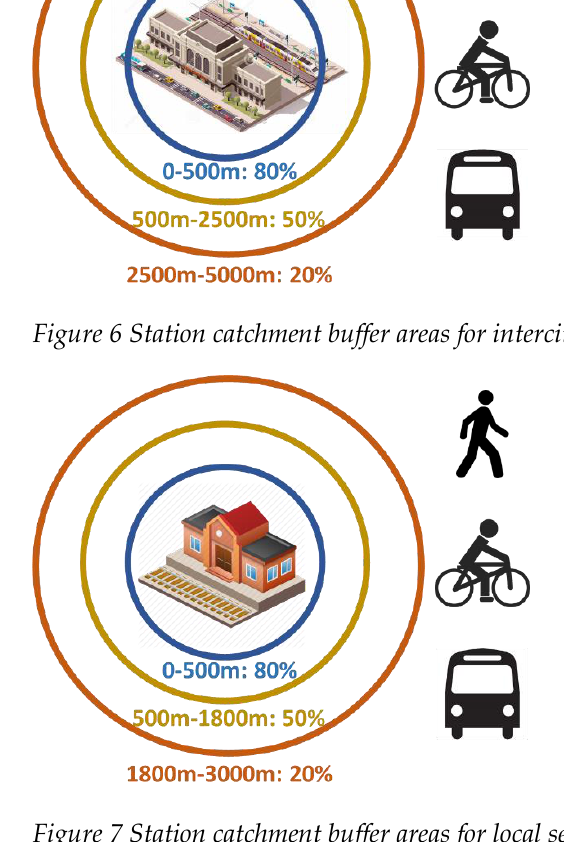
Figure 7 Station catchment buffer areas for local service